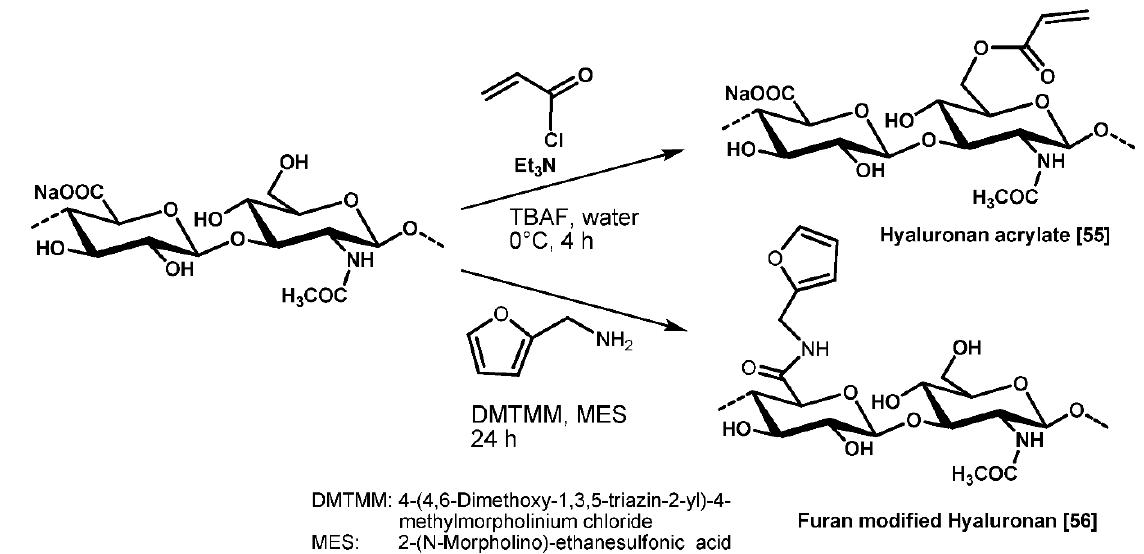
Figure 3. Introduction of reactive functional groups into GAGs, shown exemplarily with HA.